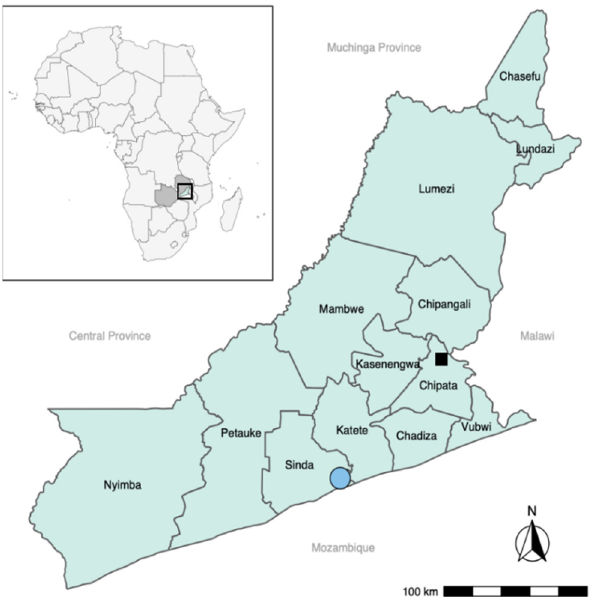
Figure 2. Map showing the study area in Eastern province of Zambia. The study area was the catchment area of Mtandaza Rural Health Centre in Sinda District (blue circle). CT scans were performed in Chipata Central Hospital in Chipata District (black square).